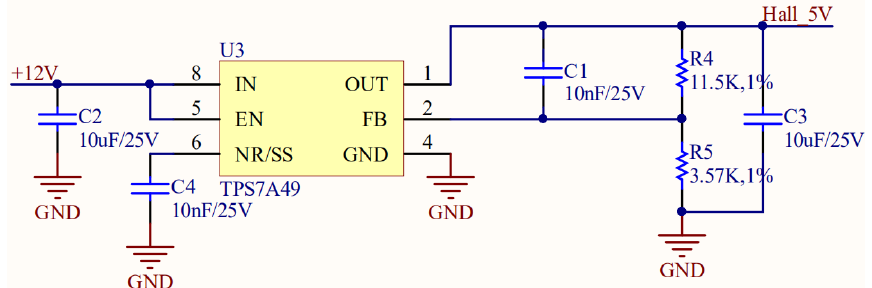
Figure 4. The Hall power supply circuit of the